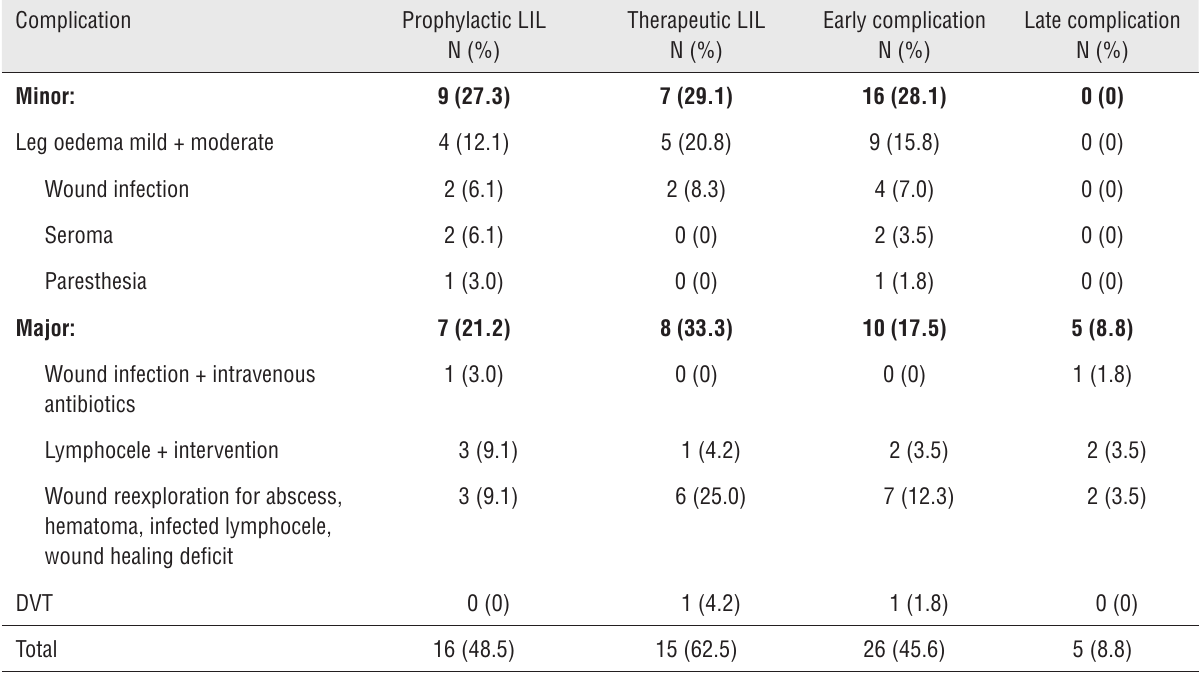
Table 3 - 31 clinically relevant complications associated with 57 LILs. In brackets - complication rates. Complication rates of prophylactic and therapeutic LIL presented in relation to respectively performed LILs, early and late complication rates related to all